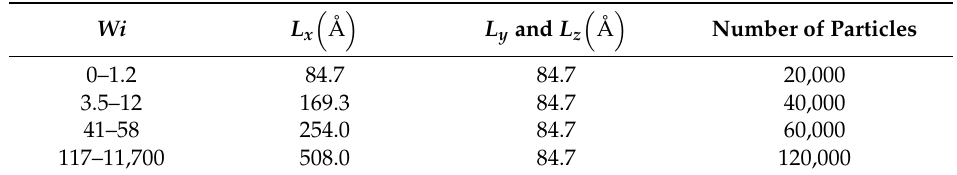
Details of the simulation cells: L x , L y , and L z are box lengths in the x , y , and z dimensions, respectively. Wi L x